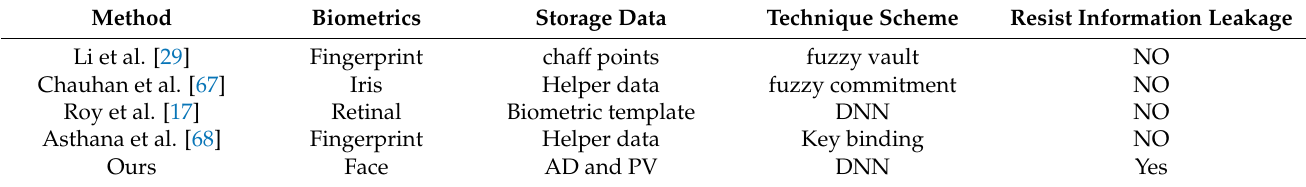
Table 5. Comparisons with other related